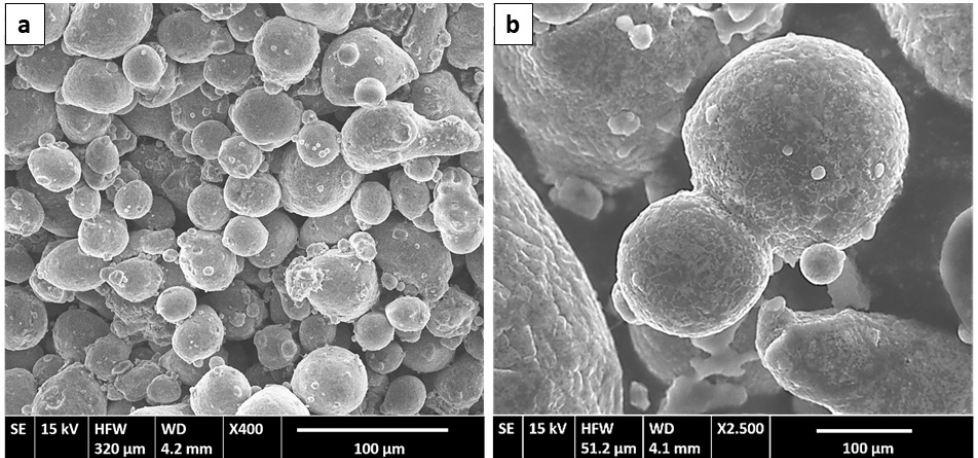
Figure 1. As–received AA 7075 powders. ( a ) General morphology of the powders; ( b ) surface morphology of single particles.